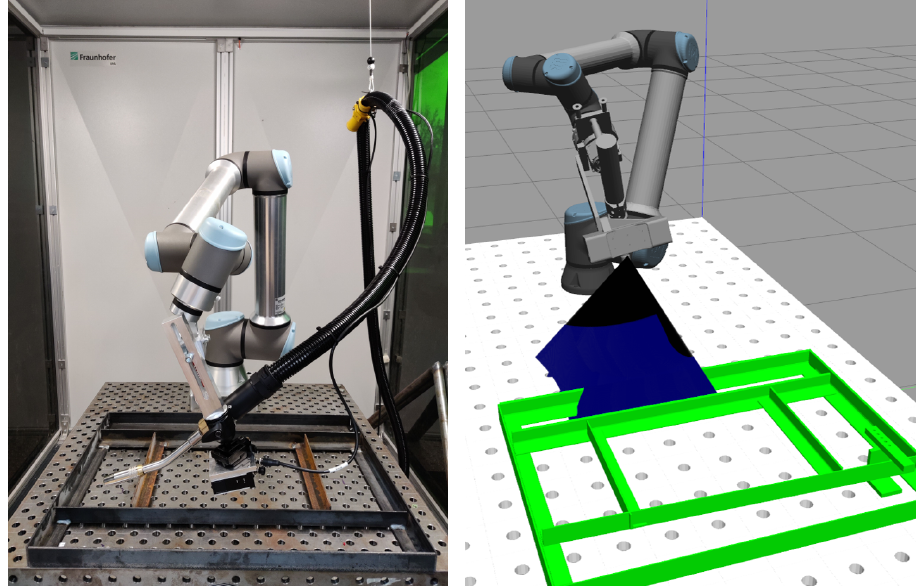
Figure 1. Exemplary robot cell in real-world ( left ) and simulation ( right